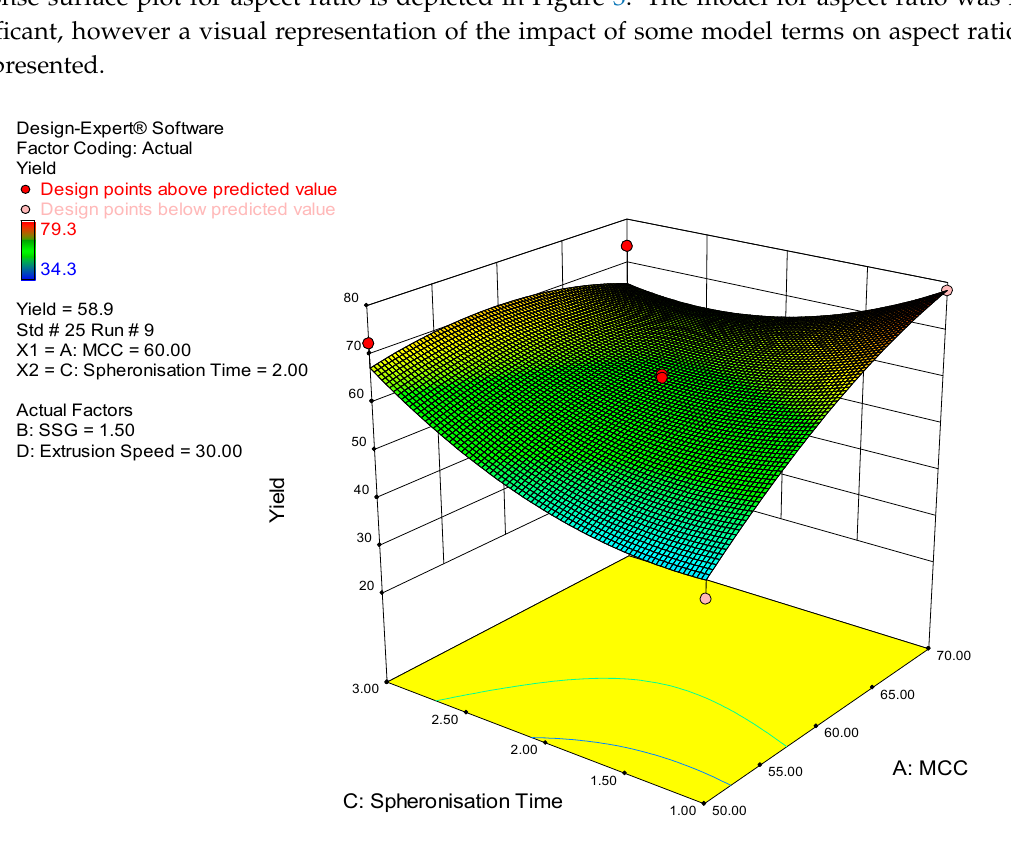
Figure 2. 3D response surface plot depicting the impact of microcrystalline cellulose concentration and spheronization time on % yield.